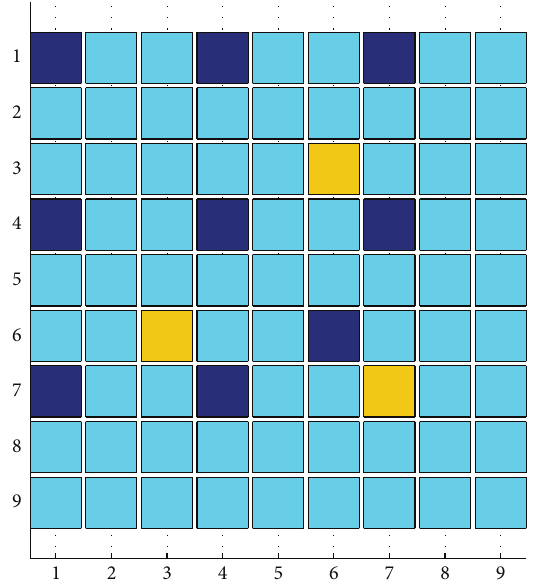
Figure 1: Lower right quarter of the 17 × 17 U-G fuel assembly. The light blue color represents the 4.4% enriched uranium fuel rods. The yellow color represents the 2.8% enriched uranium with 6% Gd 2 O 3 fuel rods. The dark blue color represents the guide